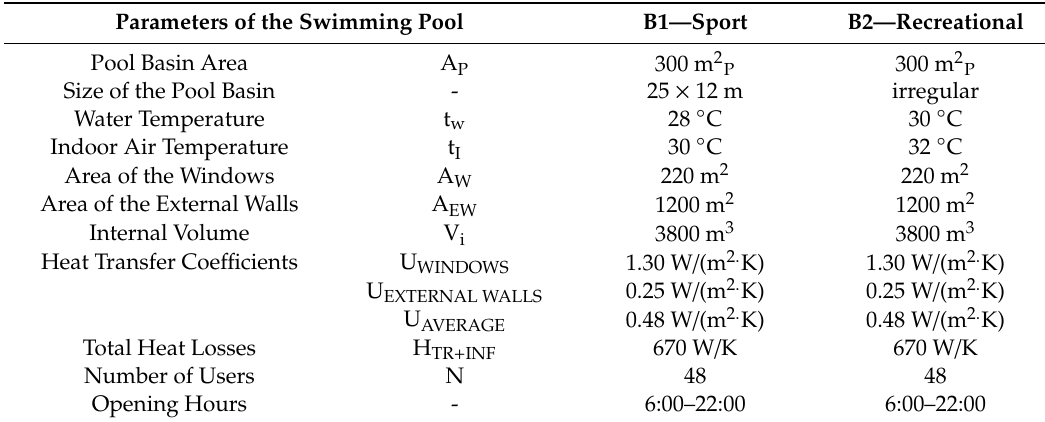
Table 2. General data of the analyzed pool for the two variants B1 and